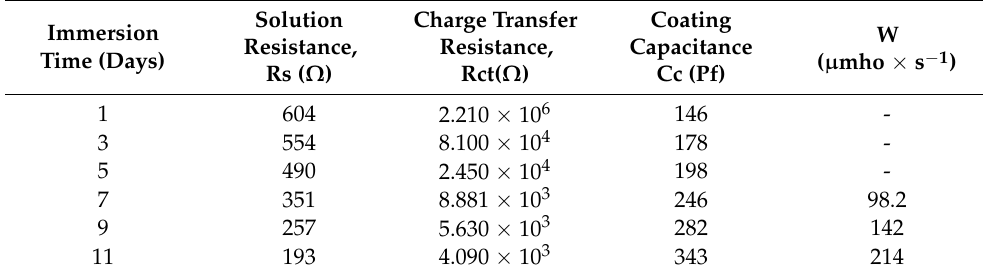
Figure 9. EIS spectrum of CPEEUA/FS conducted in 3.5 wt% NaCl solution (corrosive medium) as a function of exposure times. Table 2. EIS parameters of CPEEUA/FS-40